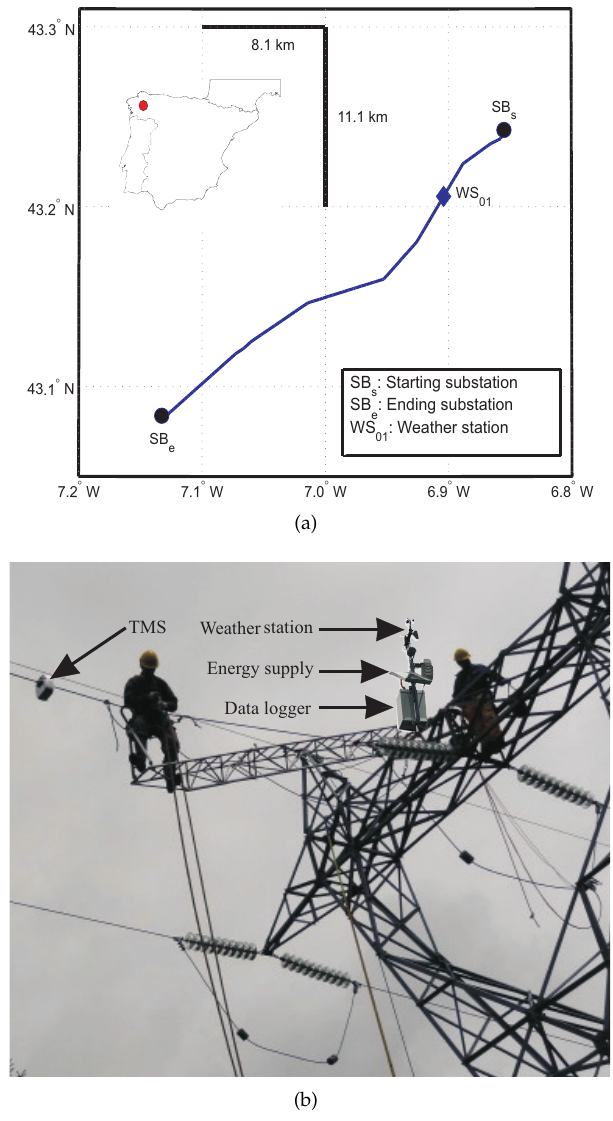
Figure 2. Description of the line and the system components. ( a ) 132 kV overhead transmission line located in northern Spain; ( b ) System components of the conductor temperature and meteorological data monitoring at the